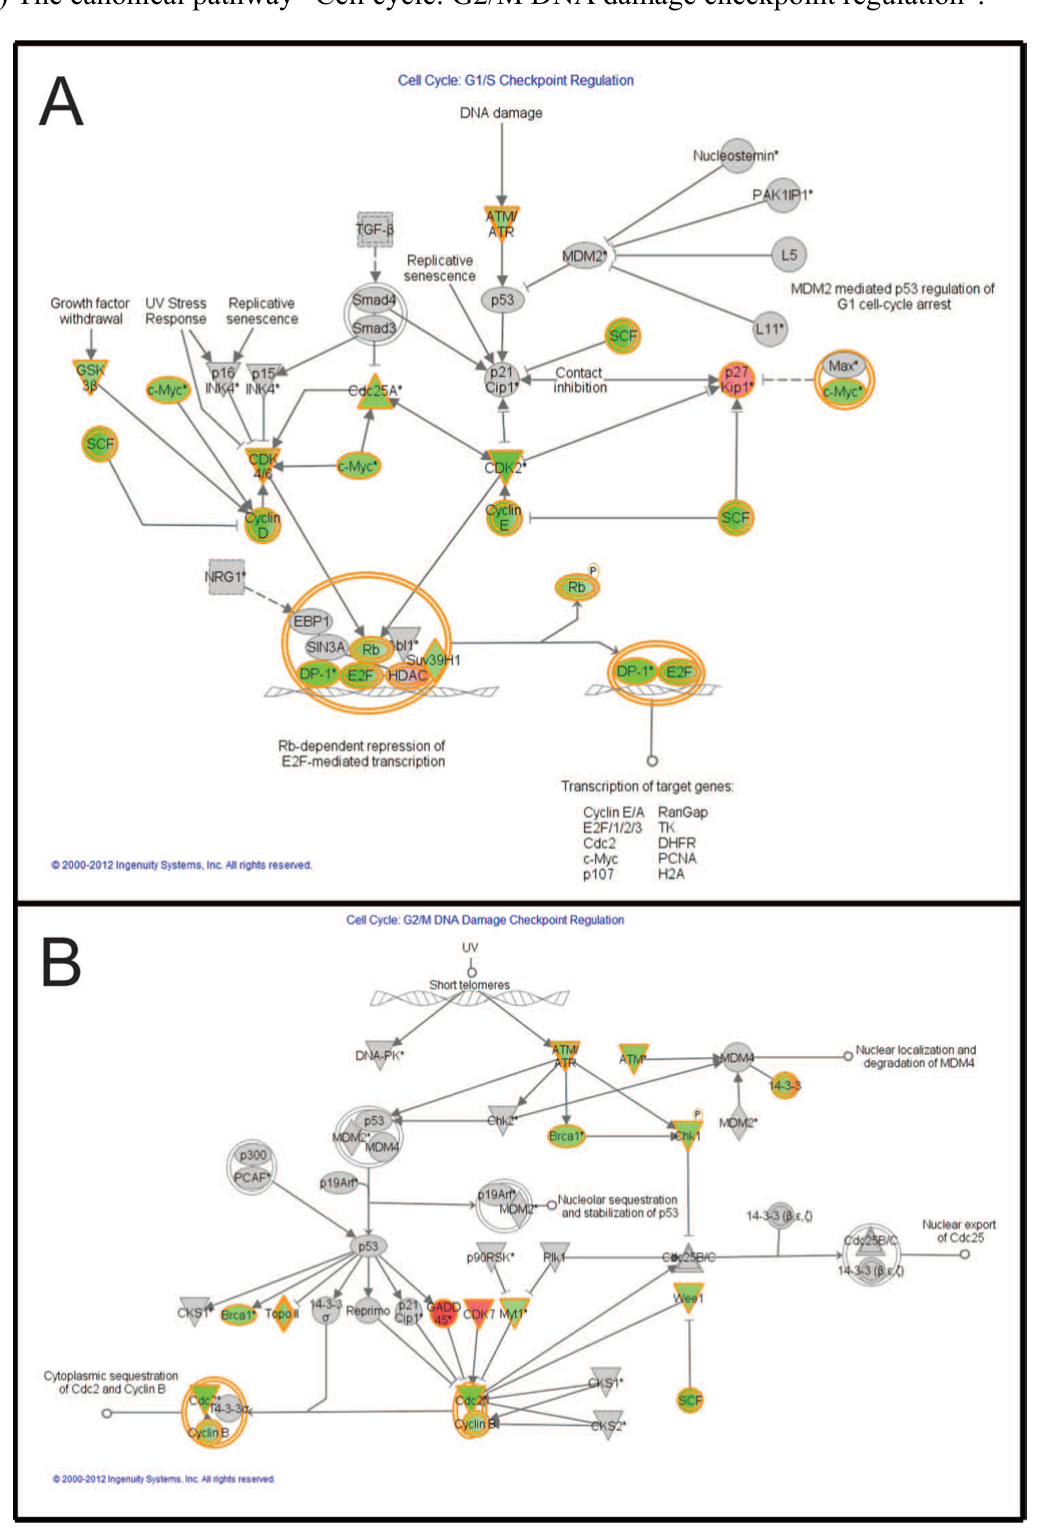
Figure 6. Graphical representation of two of the top score networks identified by Ingenuity Pathway Analysis (IPA). Canonical pathways from Ingenuity for combination treatment (5 µM vemurafenib and 5 µM temsirolimus) compared to untreated cells. Molecular relationships between genes downregulated (green) or upregulated (red) after treatment are shown. ( A ) The canonical pathway “Cell cycle: G1/S checkpoint regulation”; and ( B ) The canonical pathway “Cell cycle: G2/M DNA damage checkpoint